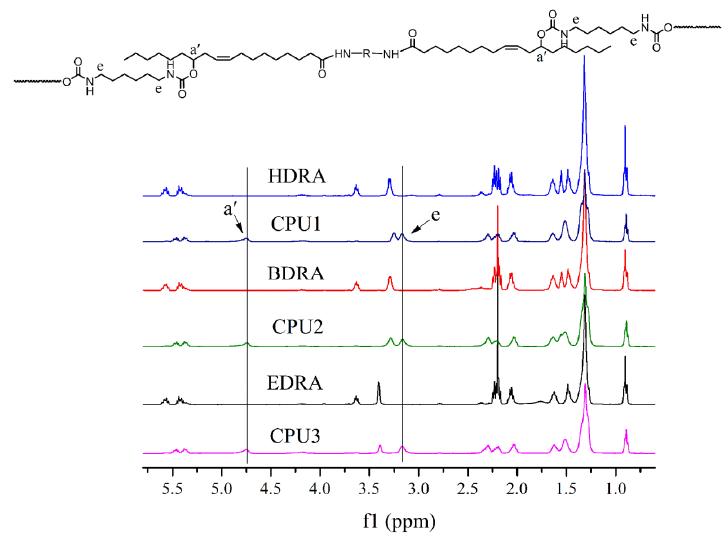
Figure 2. 1 H ‐ NMR spectra of EDRA, BDRA, HDRA, as well as their corresponding CPU products. Figure 2. 1 H-NMR spectra of EDRA, BDRA, HDRA, as well as their corresponding CPU products.